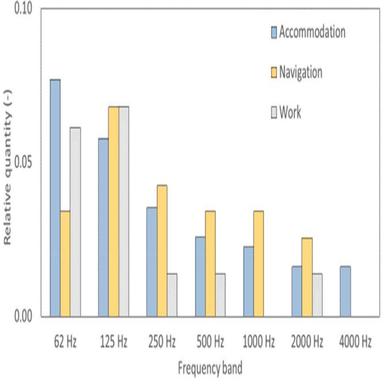
The number of suspected cases of intrusive tonal bands (definition based on the presence of levels higher than 3 dB compared with neighboring bands).